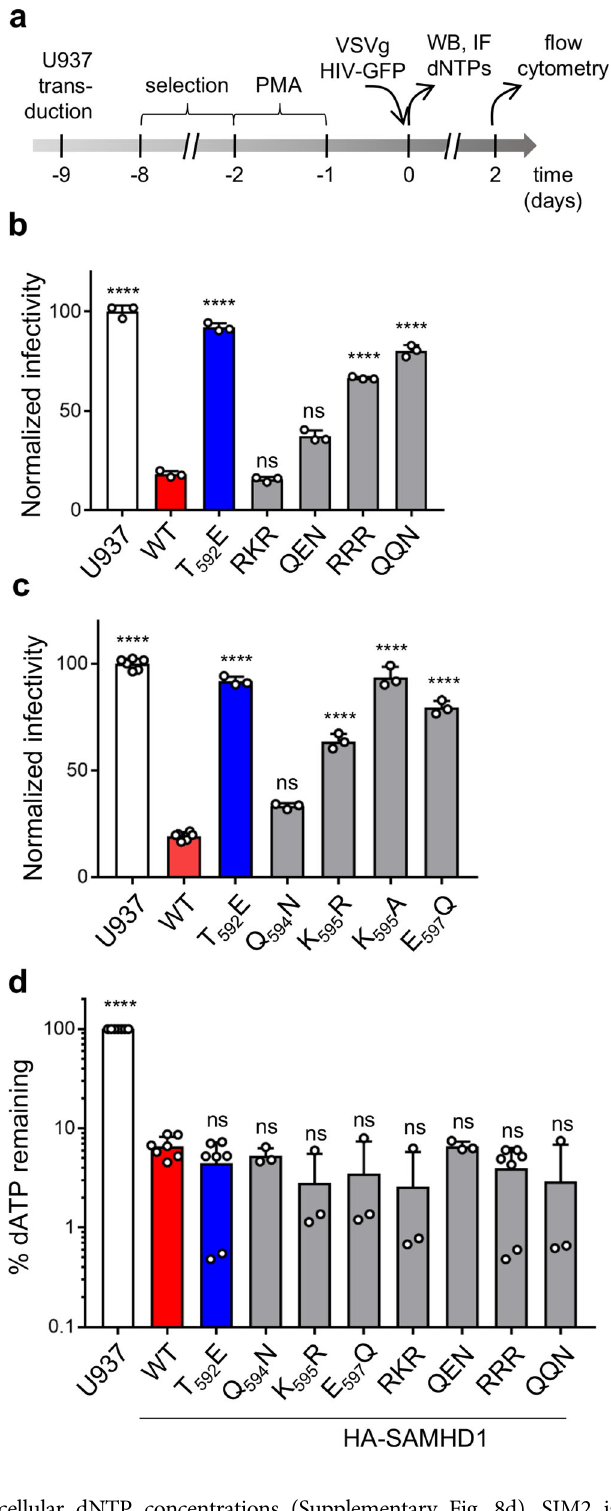
cellular dNTP concentrations (Supplementary Fig. 8d). SIM2 is located near residue T592, which phosphorylation is recognized as a major regulator of SAMHD1 antiviral function 17,18 . Therefore, we used an anti-phospho-T592 species-speci fi c antibody to monitor the degree of modi fi cation of SAMHD1 SIM2m mutant expressed either stably in differentiated U937 cells or transiently in cycling 293T cells. In both cell types, SAMHD1 SIM2m variant was phosphorylated at levels comparable to that of WT SAMHD1 (Supplementary Fig. 8b, c).